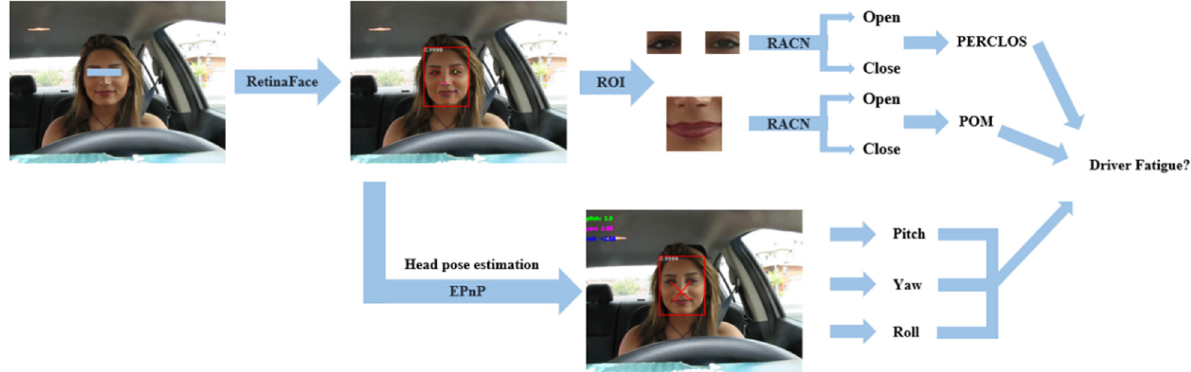
Figure 1. The overall structure of driver fatigue state detection.